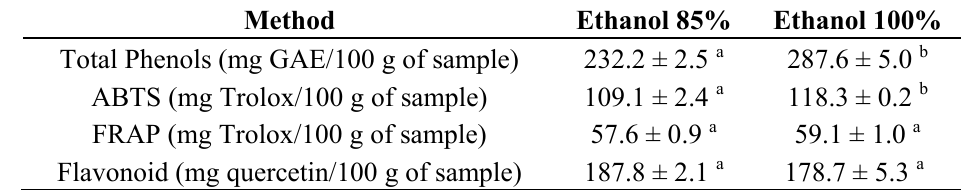
Table 4. Antioxidant activities, polyphenolic and flavonoid content of red onion extracts measured through different